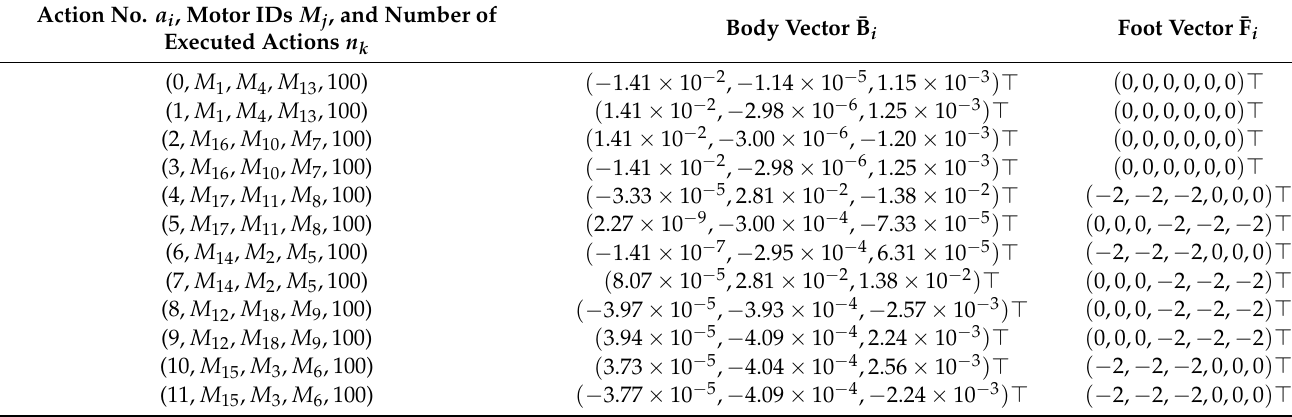
Table 2. Results of body calibration in virtual agent. This agent has motor IDs M 1 to M 18 . Action No. a i , Motor IDs M j , and Number